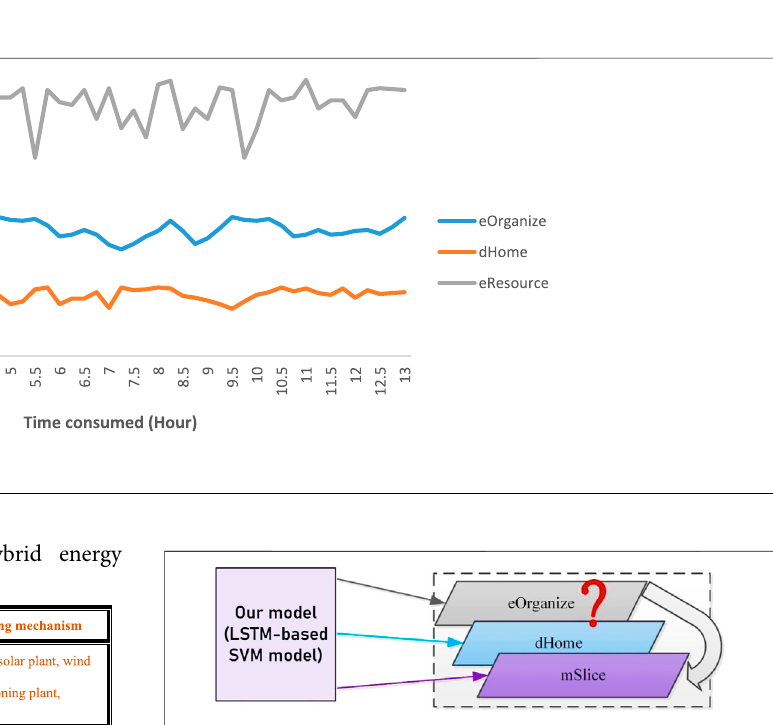
FIGURE 4 | Load overloading error in eOrganize slice and automatic allocation of requests to